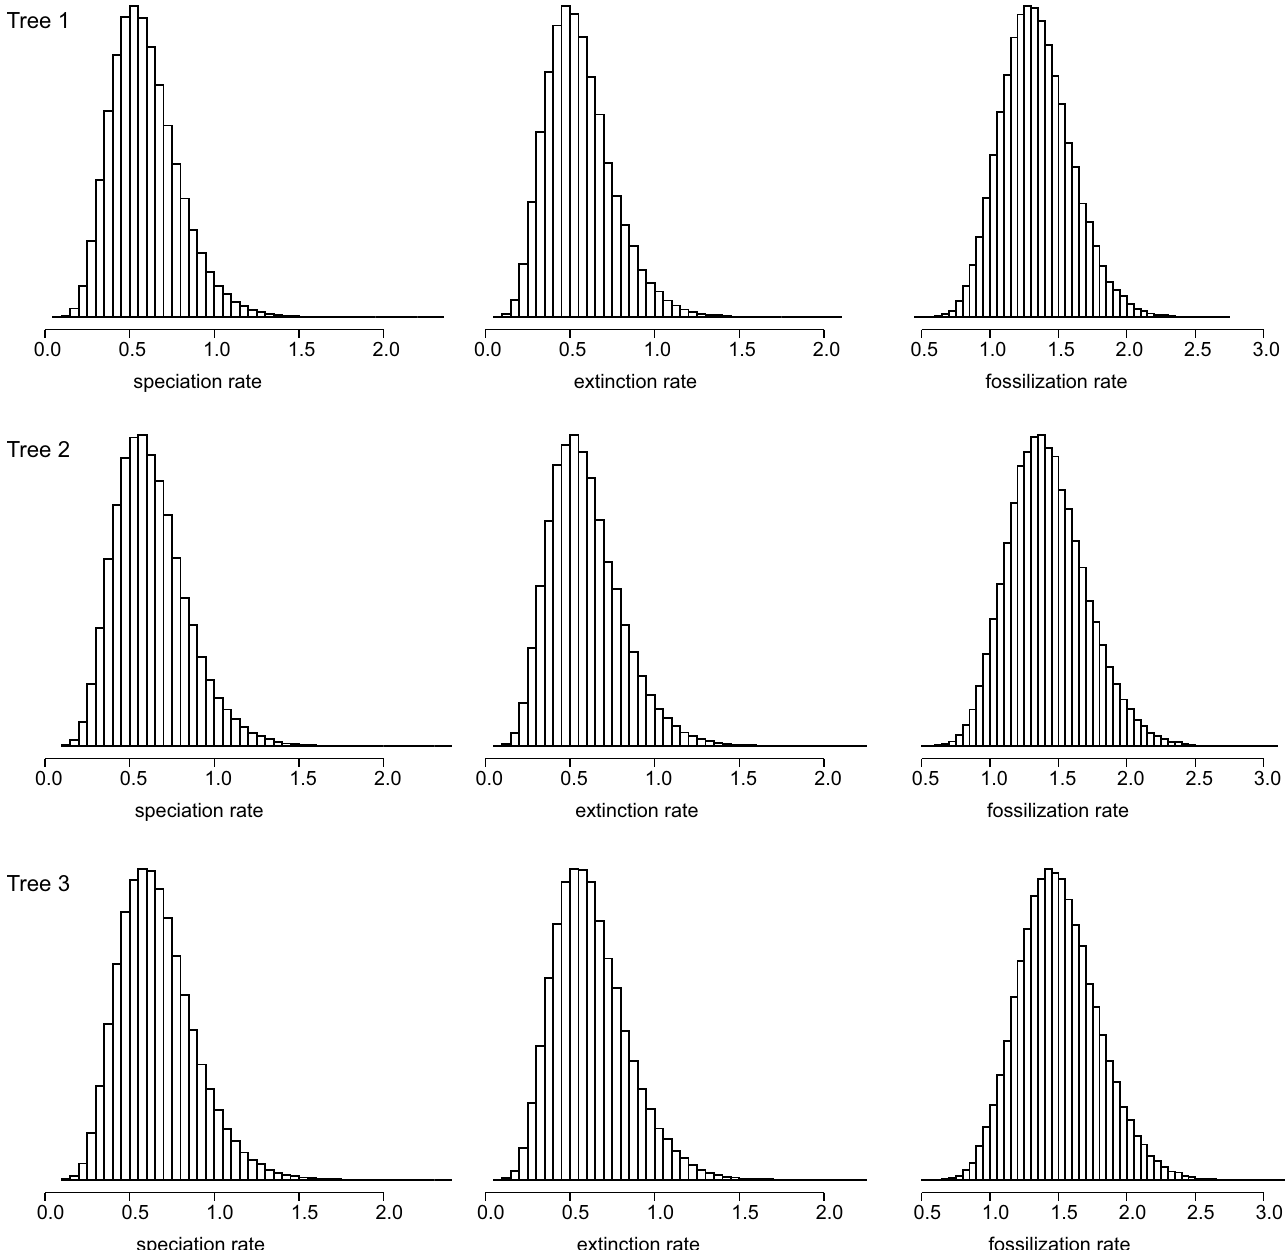
Fig. 1. Probability density histograms of speciation (cladogenesis), extinction and fossilization rates for the three equiparsimonious trees. All rates are in events per lineage and per million years. The height of each box of the plots is proportional to the posterior probability for the corresponding rate to be in the interval delineating its